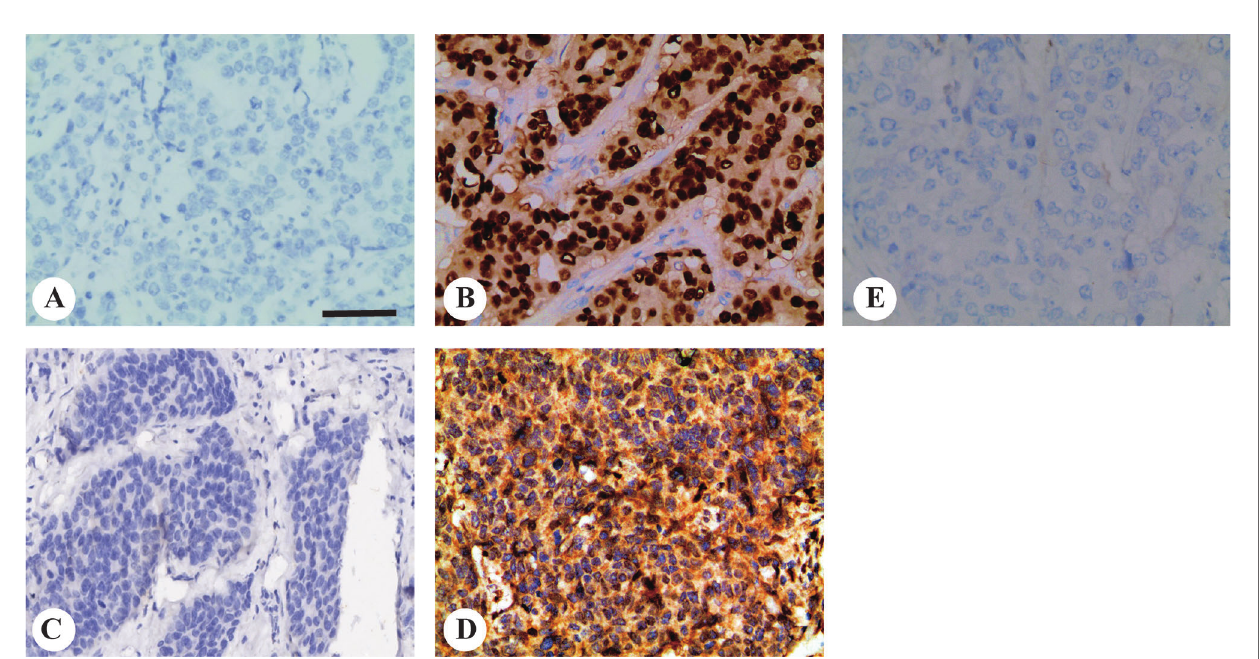
FIGURE 1 | Representative images of mutant p53 and Twist1 immunohistochemical staining in invasive breast carcinomas. Representative immunohistochemistry images for (A) mutant p53-negative and; (B) mutant p53-positive; (C) Twist1-negative and; (D) Twist1-positive; (E) Negative control IgG staining. Original magni fi cation, 200× The scale bar represents 200 m